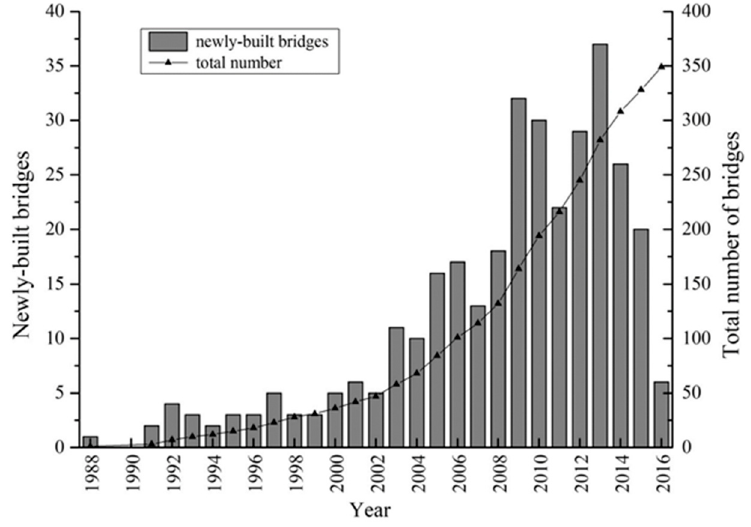
Figure 1. Newly built and total number of continuous reinforced concrete rigid-frame (CRCR) bridges in China [1].